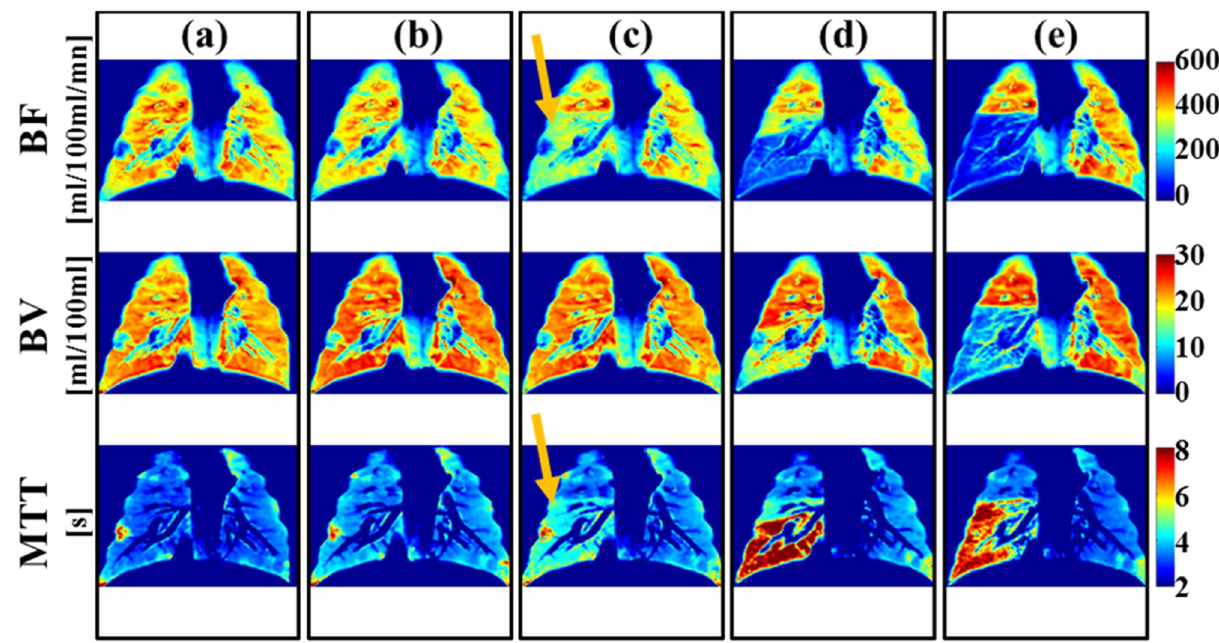
Figure 1. An example of blood flow ( BF , ml/100 ml/mn), blood volume ( BV , ml/100 ml), and mean transit time ( MTT , s) of perfusion maps generated for one of the pigs for all dynamic perfusion exams. A perfusion map color bar scale is also displayed at the right of each row to determine the corresponding perfusion values. Each column, which includes BF , BV and MTT maps, corresponds to one data set that was used to perform the qualitative perfusion defect detection using a randomized blinded approach. In this example, the two readers gave identical results for the presence/absence of perfusion defects. In (a,b) , where occlusions were 0% and 40%, the readers indicated that no perfusion defect could be detected in any of the maps. In (d,e) , where occlusions were 90% and 100%, the readers noted the presence of perfusion defect in all maps. In (c) , where the